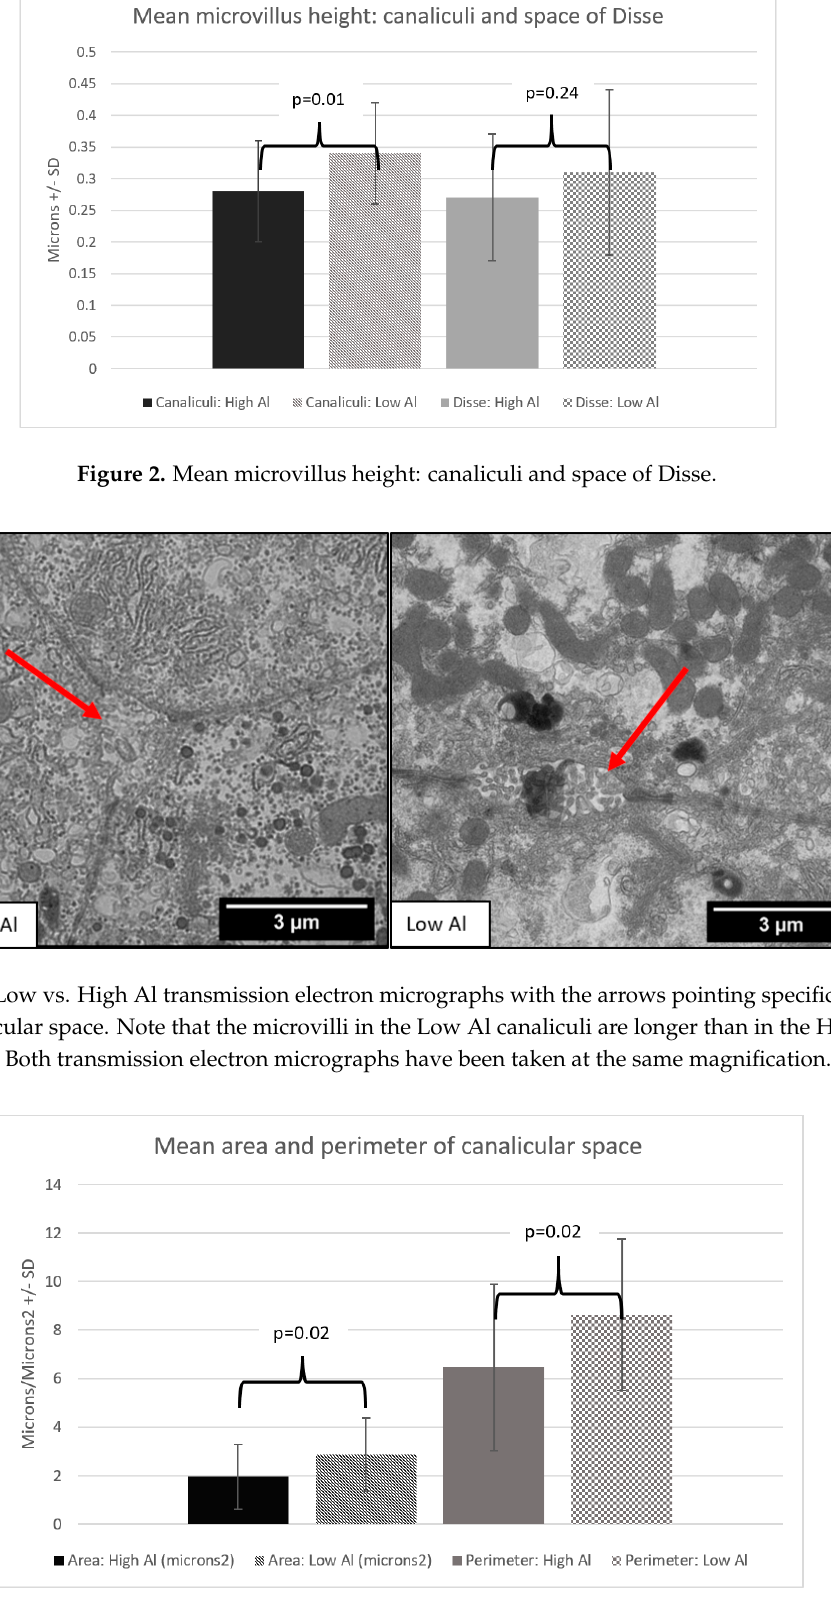
Figure 5. Mean density of microvilli: Canalicular and space of Disse.